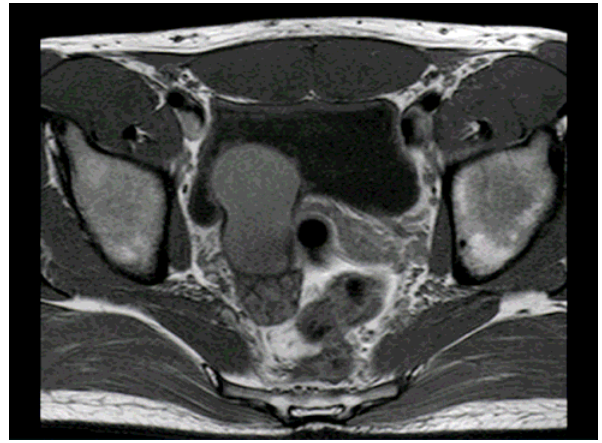
FIGURE 2. DCE-eMRI exhibiting a